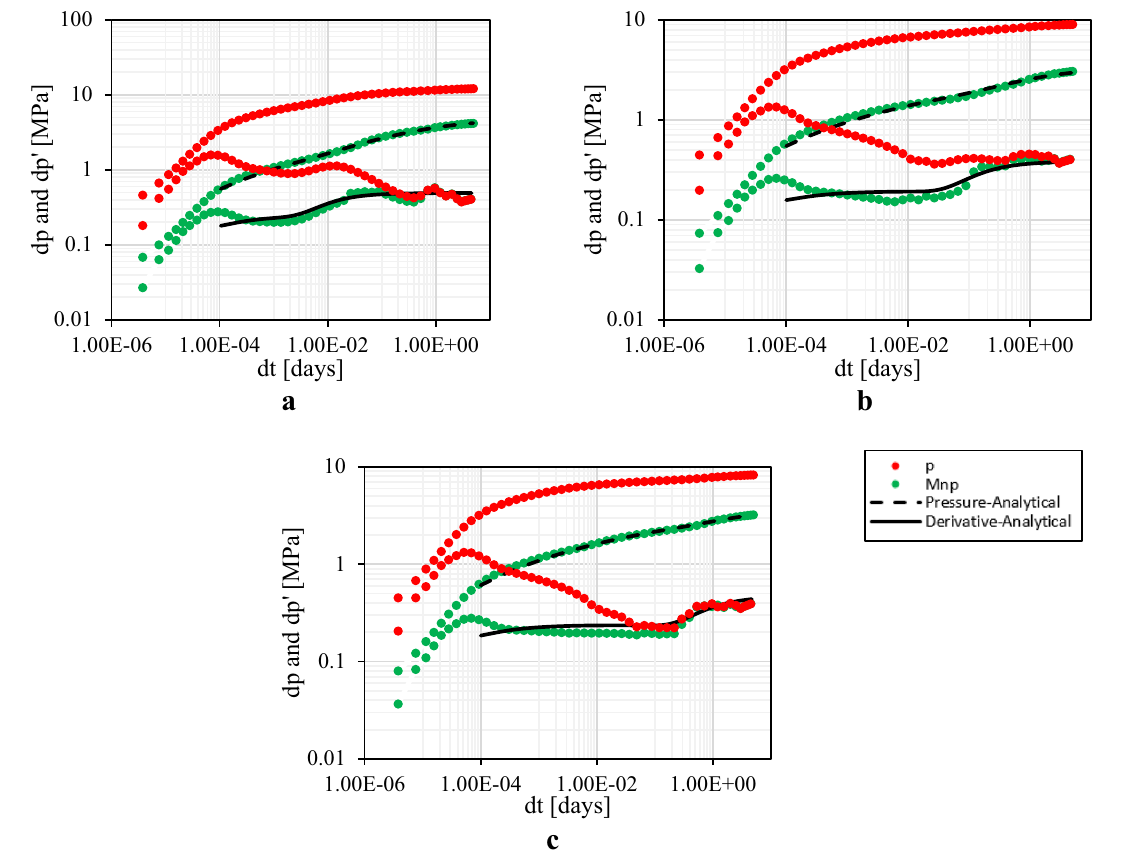
Fig. 14 Comparison of pressure and two-phase pseudo-pressure in faulted reservoir; a case 8 ( L = 2.74 m), b case 9 ( L = 10.67 m), and c case 10 ( L = 36.58 m)) Table 6 Results of BU1 test using normalized two-phase pseudo-pressure in faulted